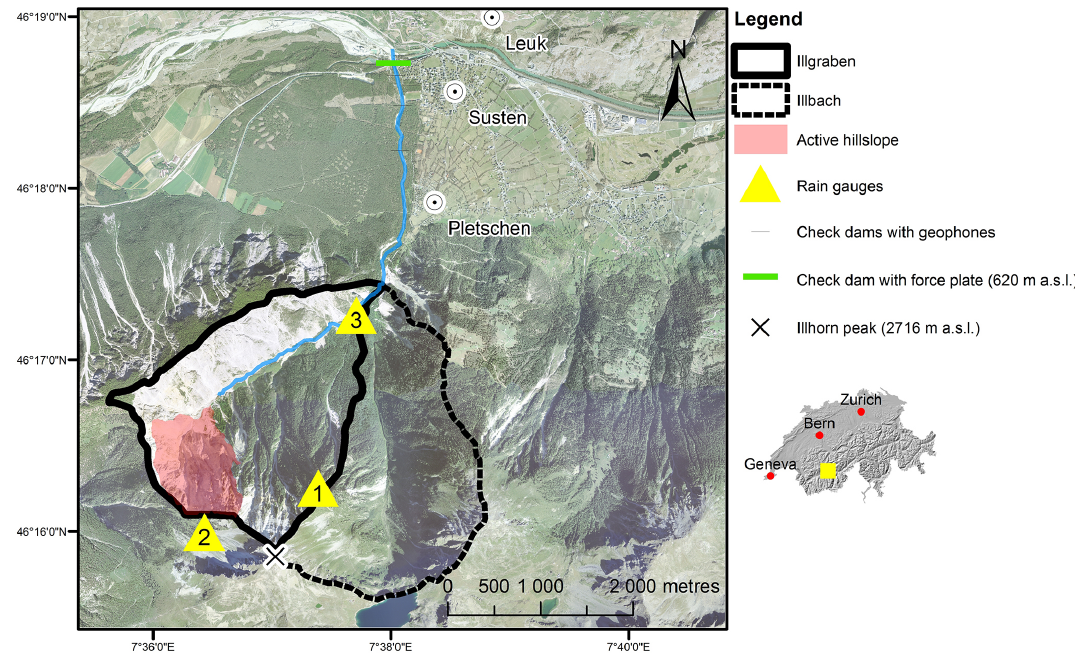
Figure 1. Aerial view of the Illgraben study site (Federal Office of Topography) with the debris-flow observation station. Most sediments are generated on the active hillslope. Debris flows mostly initiate in the channel below this slope and are identified with geophones mounted to the check dams downstream. Volumes are calculated based on data collected at the location of the force plate. Data from rain gauge 1 were used in this study to characterize rainfall